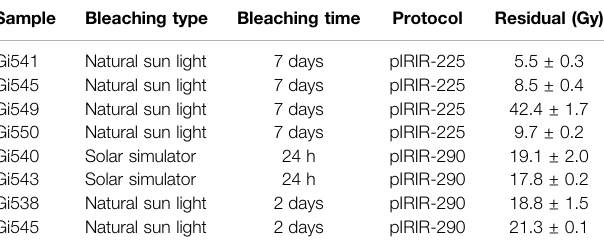
TABLE 2 | Residual signals measured for the pIRIR-225 and pIRIR-290